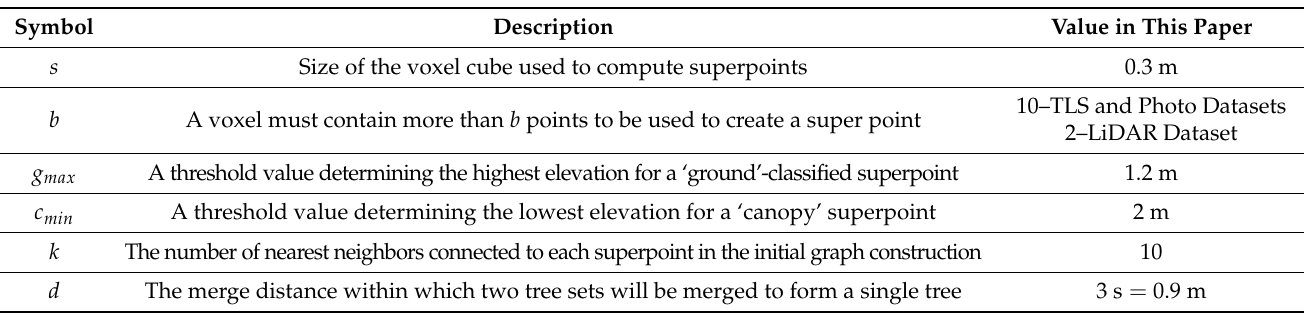
Table 3. A list of the user-defined parameters used in the proposed algorithm. Description Value in This Paper